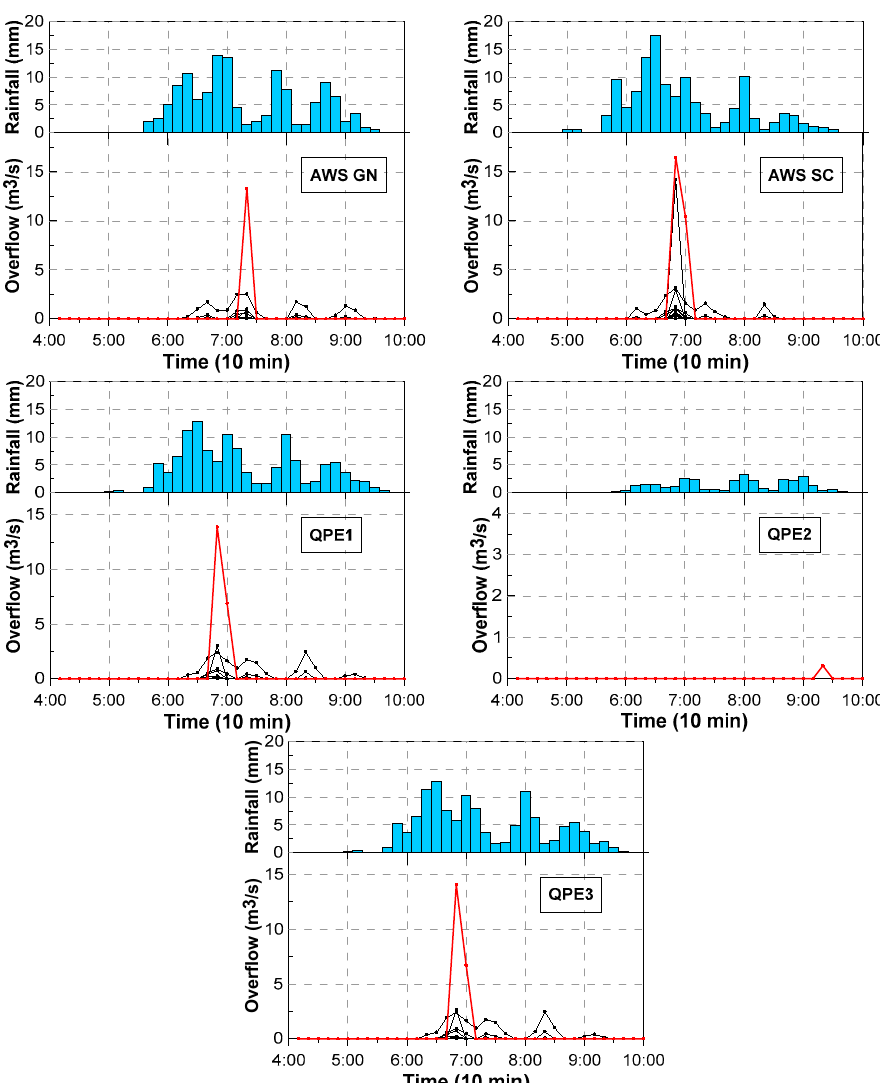
Figure 10. Timeseries overflow of each QPEs at all flooding occurred locations.